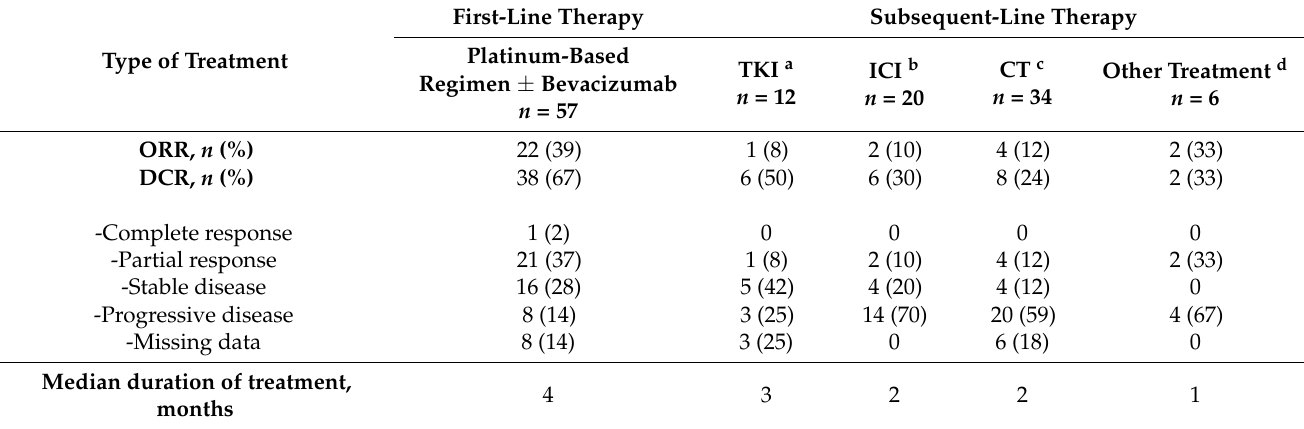
Table 3. Efficacy of subsequent therapy